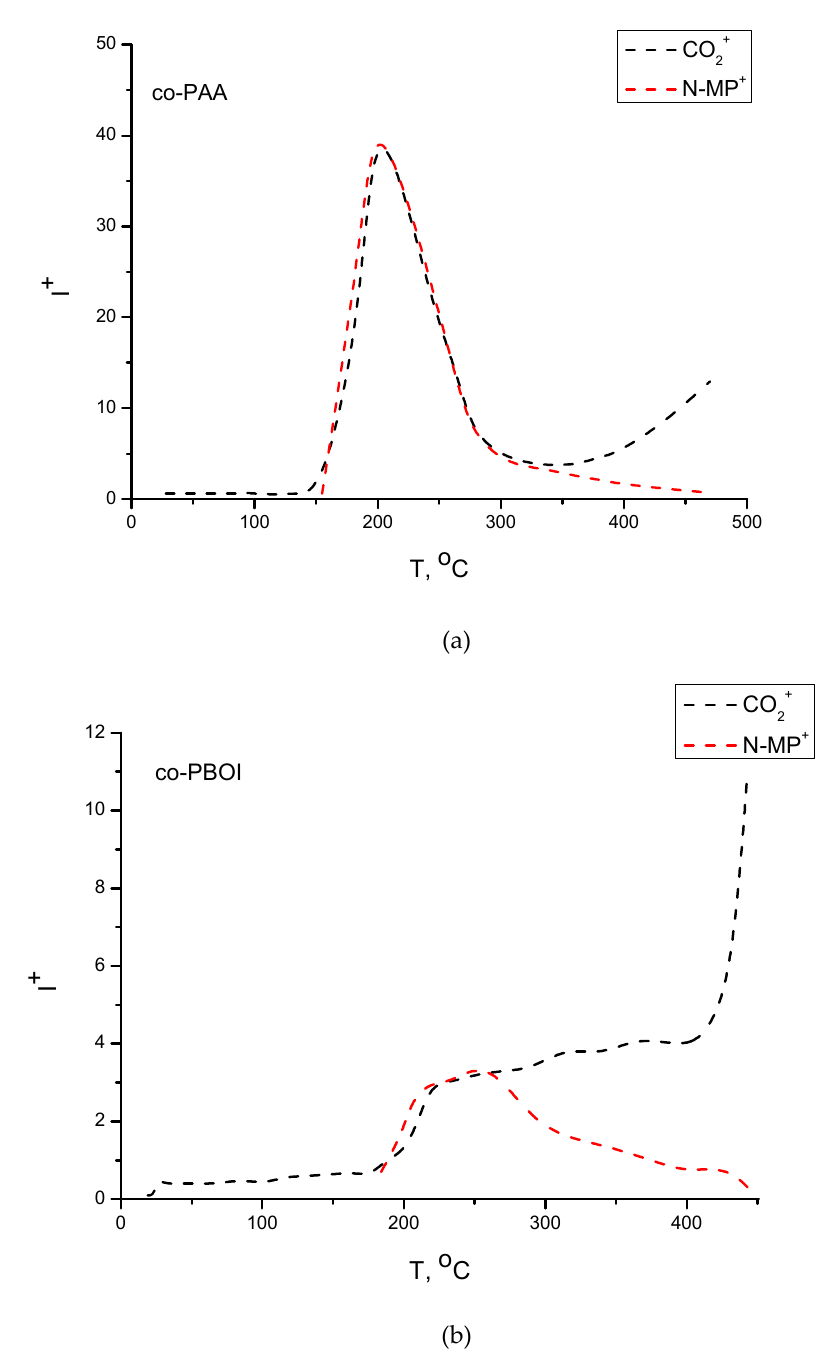
Figure 4. Temperature dependences of intensities of ion currents with m/z = 44 (black dash line, CO 2+ ion) and m/z = 99 (red dash line, NMP + ion) for ( a ) co-PAA and ( b ) co-PBOI.